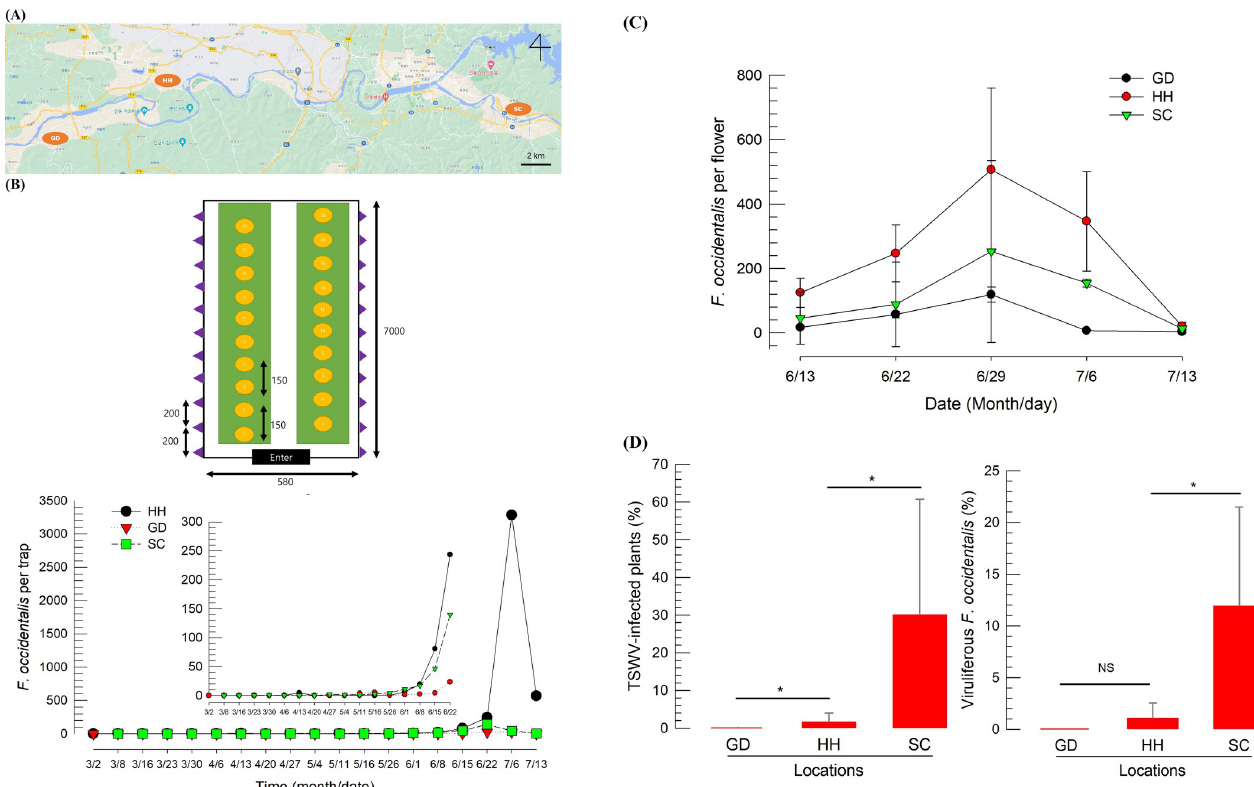
Fig 6. Application of push-pull strategy to F . occidentalis infesting hot peppers (200 plants) in a greenhouse (660 m 2 ). (A) Deployment of repellents and CAN traps in a GD greenhouse. Adult occurrence in three sites. (B) Number of F . occidentalis in flowers. Each replication represents the total number of thrips from 10 randomly selected flowers. Each measurement was replicated three times. (C) TSWV infection rates in hot peppers and F . occidentalis over one month (June 13 to July 13). Each measurement represents the percentage of diseased plants out of 100 randomly chosen hosts. Each measurement was replicated three times. To determine TSWV-infected thrips, multiplex PCR analysis was performed to discriminate viruliferous thrips. In each site/collection, 30 thrips were used to analyze the viruliferous thrips for the period. An asterisk above the standard deviation bars indicates a significant difference among means at Type I error = 0.05 (LSD test). NS indicates no significant